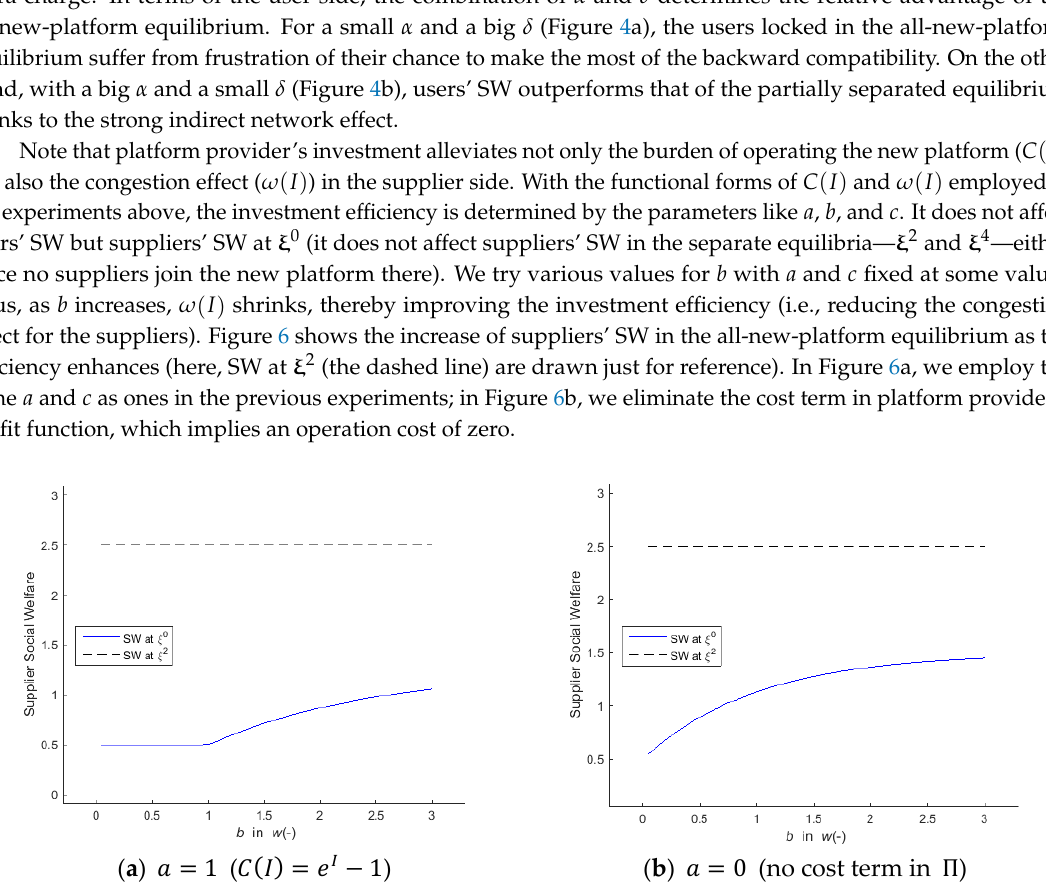
Figure 6. Suppliers ’ SW changes as the investment efficiency varies.